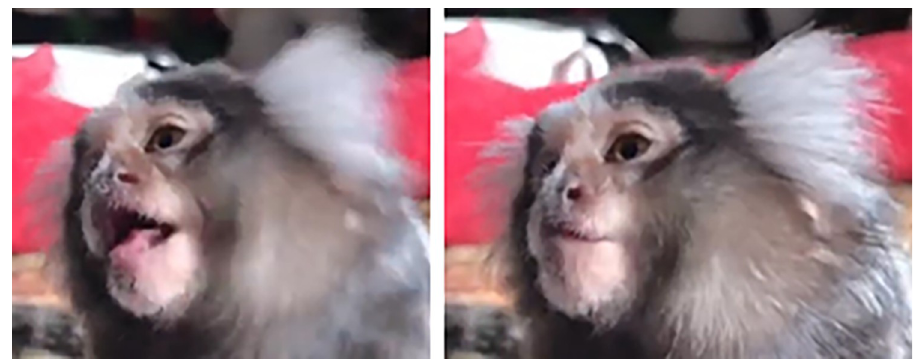
Fig 17. AU118—Lip Pucker. Left: AU25 and AU27 are present; Right: AU118 is added after mouth